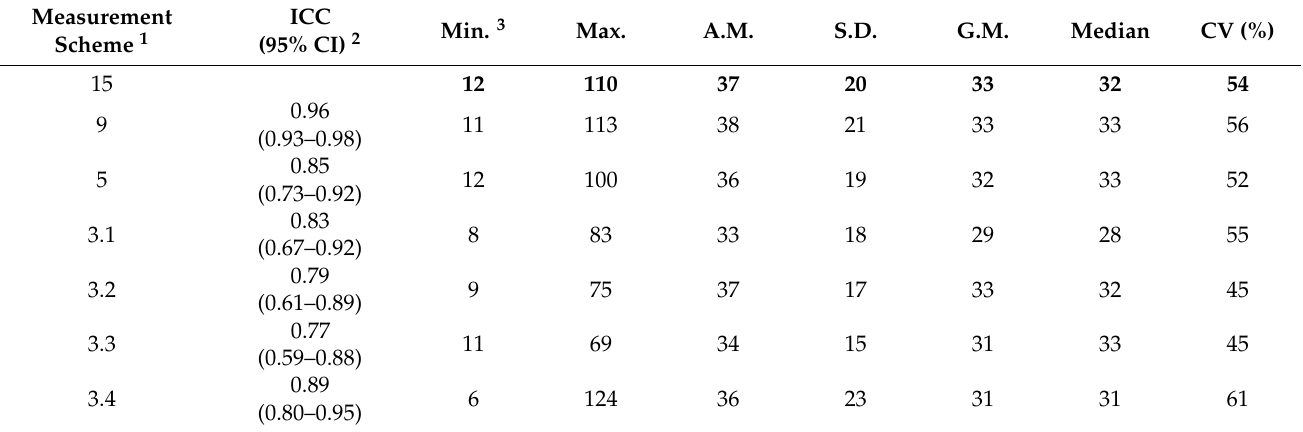
Table 1. The descriptive statistics for different measurement schemes for GRP in 34